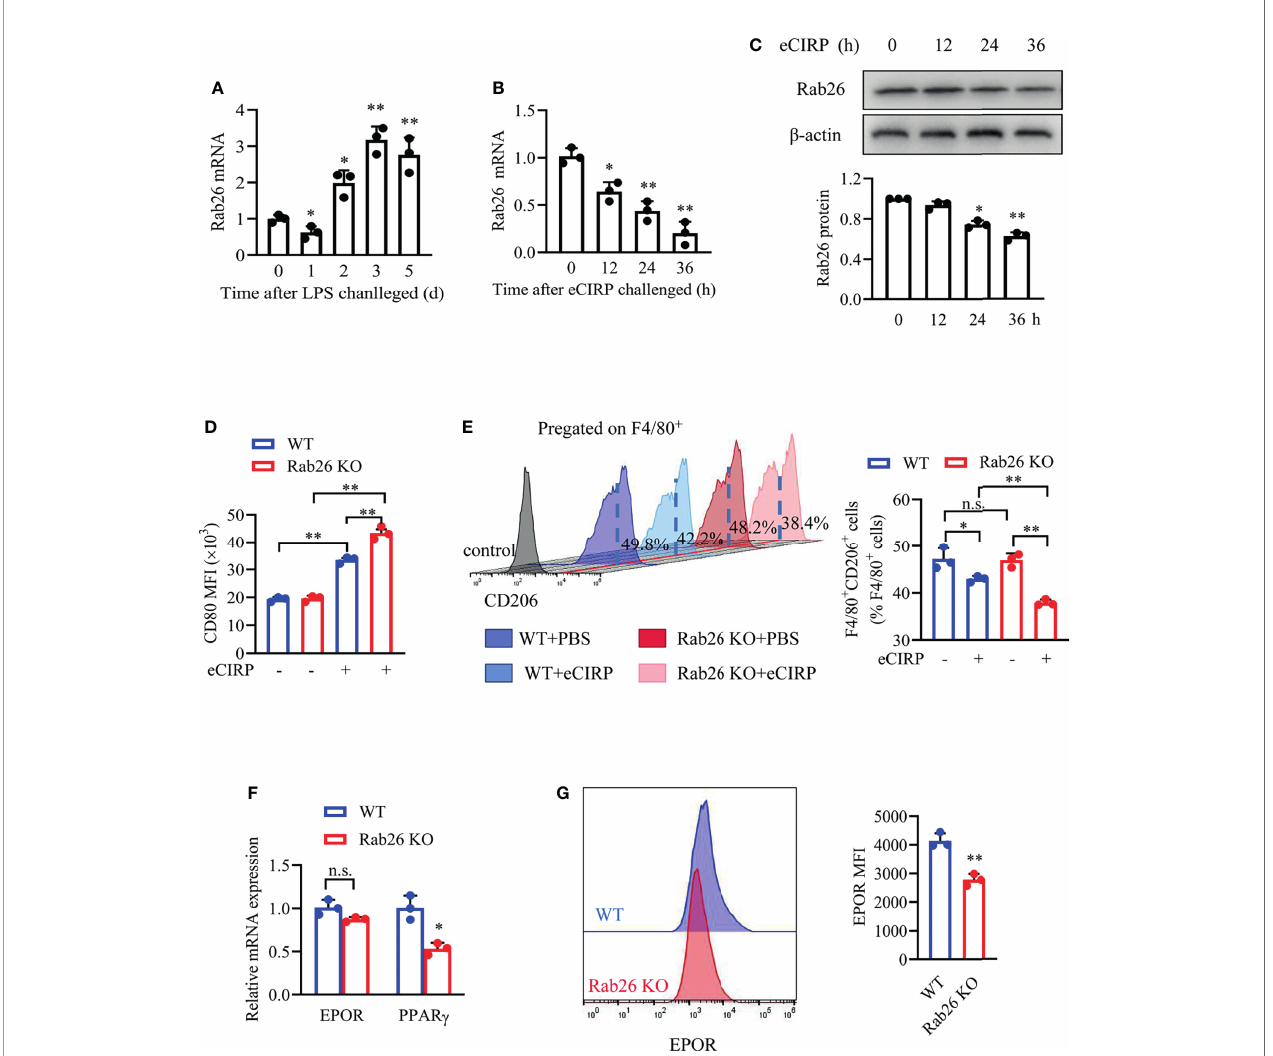
FIGURE 6 | Rab26 is critical for macrophage polarization. (A) Macrophages in BALF from WT-ALI mice (3 mg/kg LPS i.t.) were isolated by magnetic-activated cell sorting with F4/80 labeled, and qPCR analysis of the Rab26 mRNA expression in BALF macrophages was tested at the indicated times (days 0, 1, 2, 3, and 5) (n = 3). * P < 0.05, ** P < 0.01 vs. the day-0 group. A qPCR assay was conducted to evaluate the mRNA expression of Rab26, (B) and Western blot analysis of Rab26 and b -actin protein expression (C) was conducted after WT BMDMs were treated with eCIRP for the indicated times (n = 3). * P < 0.05, ** P < 0.01 vs. 0 h group. The membrane CD80 MFI of BMDMs (D) and the percentage of CD206 + BMDMs (E) were measured by FACS with or without eCIRP (1 µg/ml) administration for 24 h (n = 3). (F) A qPCR assay was conducted to evaluate the mRNA expression of EPOR and PPAR g in WT and Rab26 -/- BMDMs (n = 3). (G) The membrane EPOR of WT and Rab26 -/- BMDMs was evaluated by FACS (n = 3). * P < 0.05, ** P < 0.01 vs. WT group. Data are representative of at least two independent experiments. Results were expressed as mean ± SD. n.s., not statistically signi fi cant. * P < 0.05, ** P < 0.01. Statistics: One-way ANOVA with Tukey ’ s post-hoc test for multiple comparisons (A – E) or unpaired two-tailed Student ’ s t-test (F, G) . EPOR, erythropoietin receptor; BALF, bronchoalveolar lavage fl uid; ALI, acute lung injury; PCR, Polymerase Chain Reaction; PPAR, peroxisome proliferator-activated receptor; BMDM, bone marrow derived macrophage; eCIRP, extracellular cold-inducible RNA- binding protein; WT, wild type; EPO, erythropoietin; MFI, mean fl uorescence intensity; FACS, fl uorescence activated cell